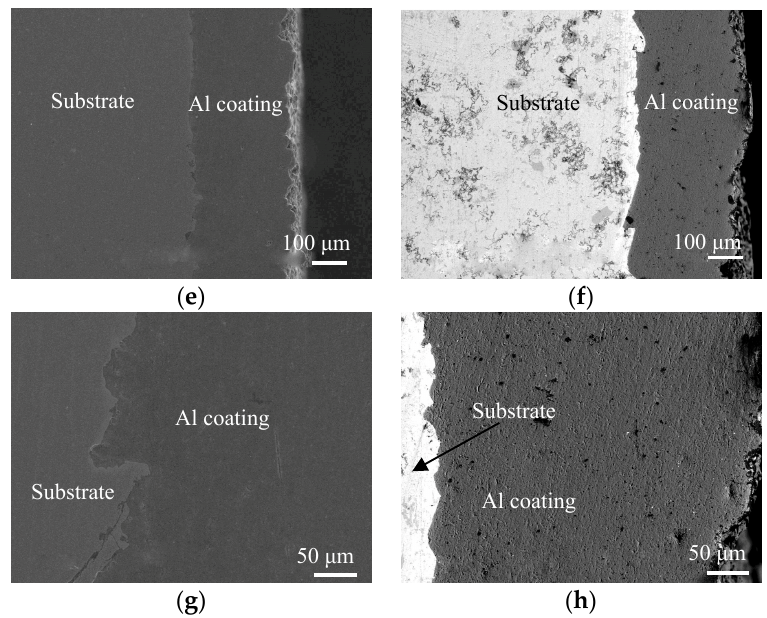
Figure 1. Surface and cross section morphologies of cold sprayed Al coating before and after laser remelting (LR). ( a ) Low-magnified surface morphology before LR; ( b ) Low-magnified surface morphology after LR; ( c ) High-magnified surface morphology before LR; ( d ) High-magnified surface morphology after LR; ( e ) Low-magnified cross-section morphology before LR; ( f ) Low-magnified cross-section morphology before LR; ( g ) High-magnified cross section morphology before LR; ( h ) High-magnified cross section morphology after LR.